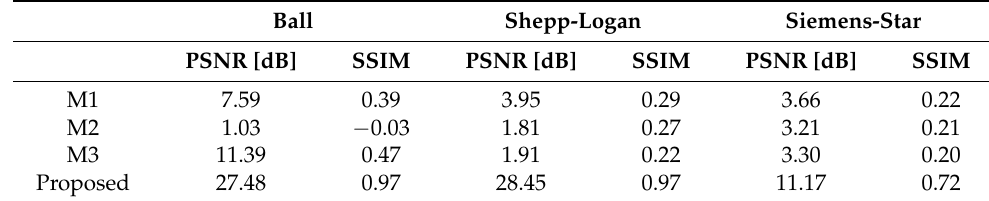
Table 2. Quantitative performance evaluation of tested methods.